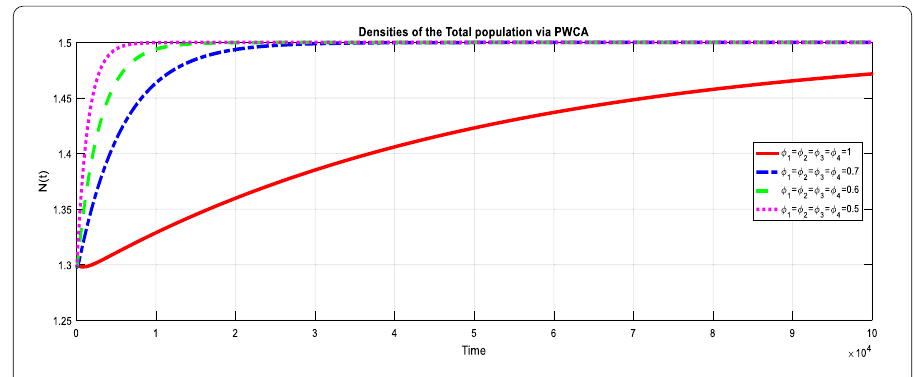
Figure 13 Dynamic of N ( t ) by varying the value of φ